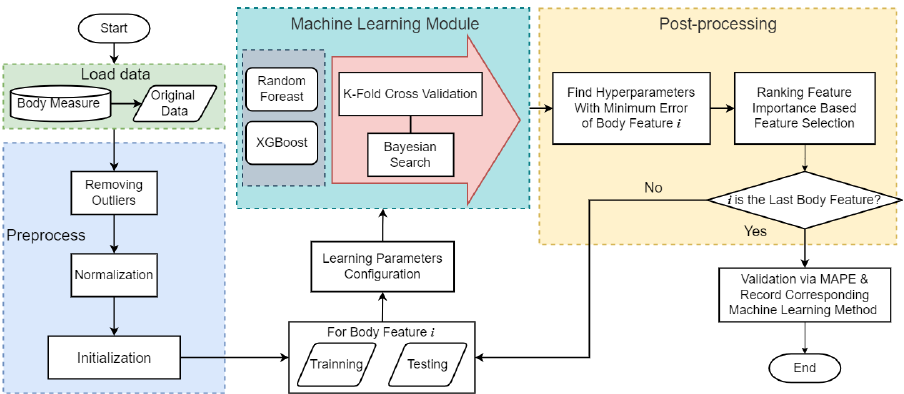
Figure 1. Illustration of proposed ML-enabled framework in 3D BM estimation.